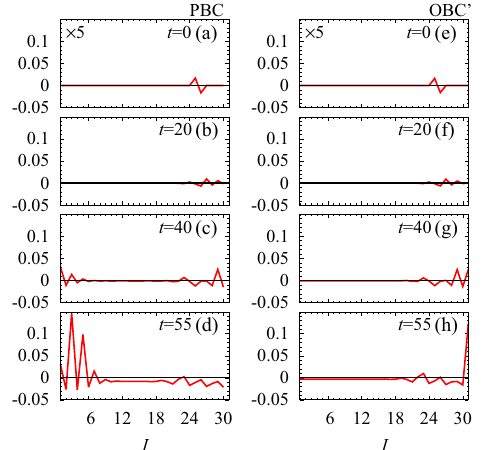
x ( t ) c for (cid:31) 15 . The horizontal 0.5 and L x = = − = − n (cid:31) t RK with = 0.1 for I 25 and δ 0 and 1 δ 0 with δ 0 + − = =